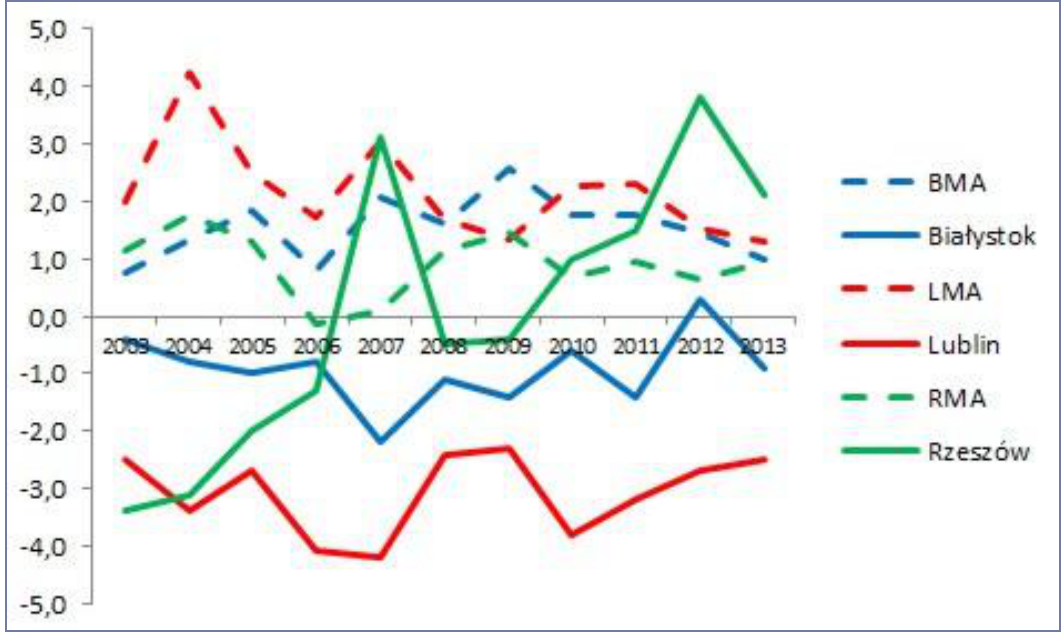
Fig. 4. Migration balance per 1000 people in the Białystok, Lublin and Rzeszów Metropolitan Areas (2002-2013) (author’s own elaboration based on data from the Local Data Bank of the Central Statistical